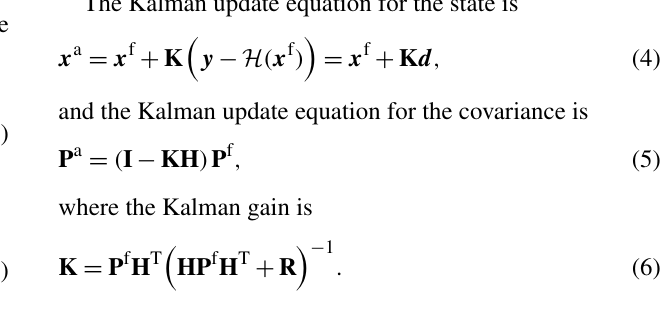
Figure 1. Schematic diagram illustrating the workflow of an offline EnKF system. Assuming the forecast model is a coupled model consisting of two components A and B , each component outputs its own results, A f updates the state of component A , and it only outputs the analysis ensemble A a N e = 5 ensemble members which run h e hours for each cycle and only output the restart files at the end of the cycle. In addition, there is a deterministic forecast that started with the optimal initial condition A a from the EnKF system, and this deterministic forecast may run longer than the period ( h e hours) of one cycle and may output more